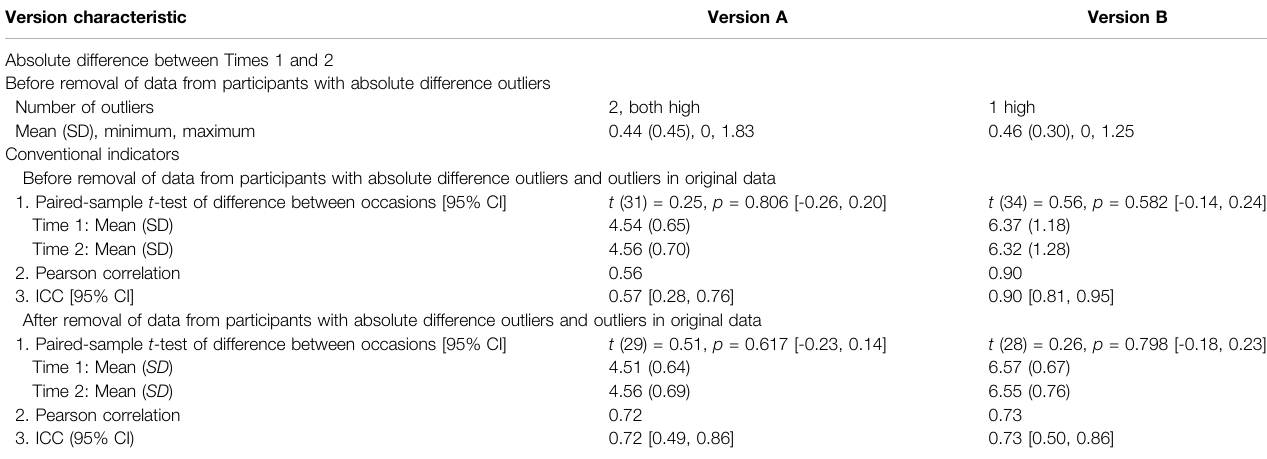
TABLE 4 | Results relevant to test – retest analyses. Version